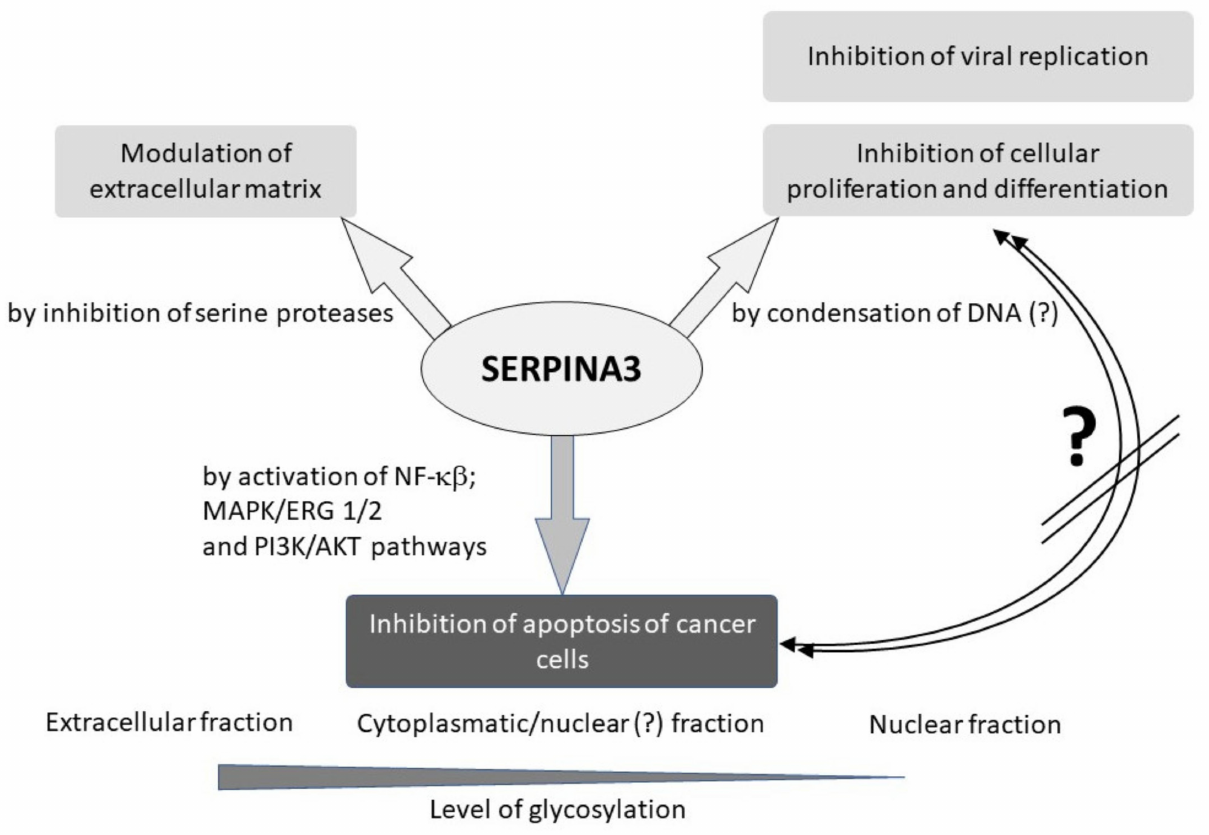
Figure 4. Possible role of SERPINA3 protein in cellular and extracellular